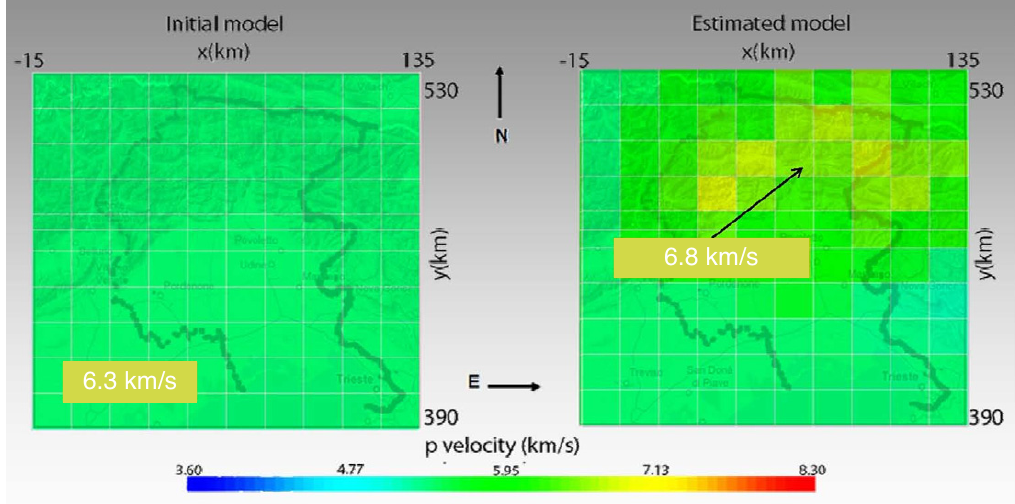
Figure 14. Tomographic inversion of the second layer in the model in Figure 2. Homogeneous initial model (left) and estimated P velocities